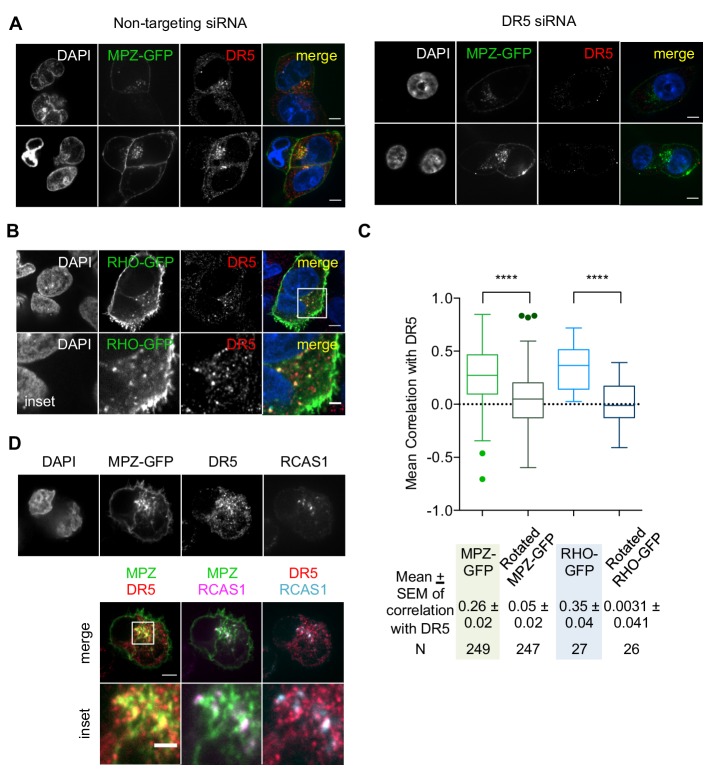
Intracellular puncta of overexpressed MPZ and rhodopsin proteins show significant co-localization with DR5 clusters.(A) Immunofluorescence of fixed HCT116 cells transfected with siRNA (left: non-targeting, right: siDR5) for 48 hr and MPZ-GFP (green in merge) for 24 hr and subsequently immunostained for anti-DR5 (red in merge). Two representative confocal images are shown for each siRNA treatment, where the scale bar corresponds to 5 μm. (B) Immunofluorescence of fixed HCT116 cells expressing RHO-GFP for 24 hr and stained for DR5 and GFP (scale bar = 5 μm, inset scale bar = 2 μm). (C) Quantification of Pearson’s correlation per cell between DR5 signal and ER-trafficked protein (MPZ and RHO) 24 hr-post transfection from original image files versus artificially rotated image files, for which the GFP channel was rotated 90o with respect to the other channel. Whisker-box plots depict the Tukey method. Statistics were performed through unpaired two-tailed t-tests, where **** indicates p<0.0001 and the variance was non-significant. (D) Immunofluorescence for DR5 and RCAS1 in fixed HCT116 cells expressing MPZ-GFP. RCAS1 is magenta in the overlay with MPZ (green) or cyan in the overlay with DR5 (red), where white puncta signify co-localized signal (scale bar = 5 μm, inset scale bar = 1 μm).